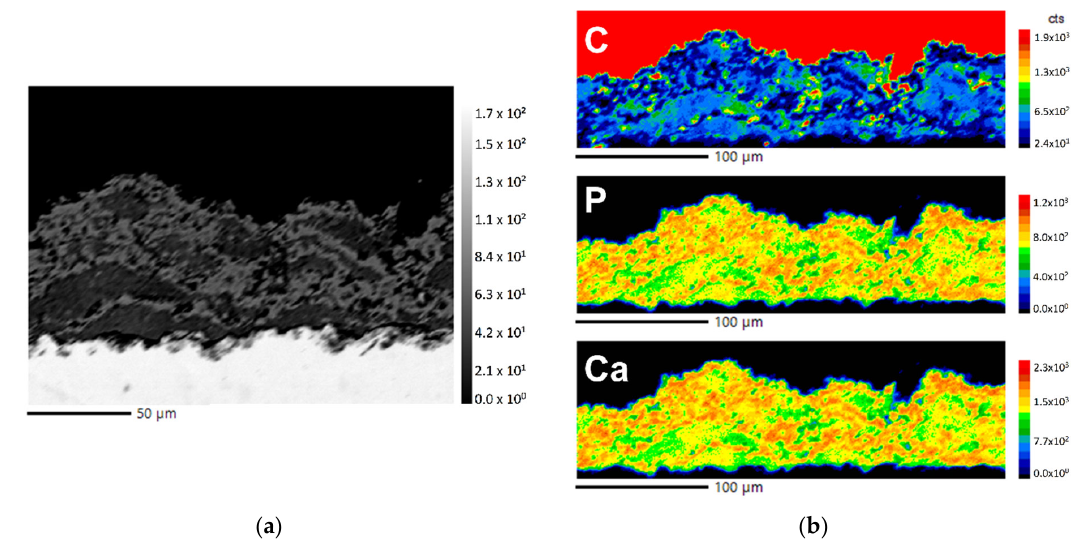
Figure 5. Element distribution of coating C3-1: ( a ) SEM image (BSE, 15 kV acceleration voltage) of coating C3-1; ( b ) wavelength dispersive X-ray spectroscopy elemental composition mapping of carbon (C), phosphorus (P) and calcium (Ca).